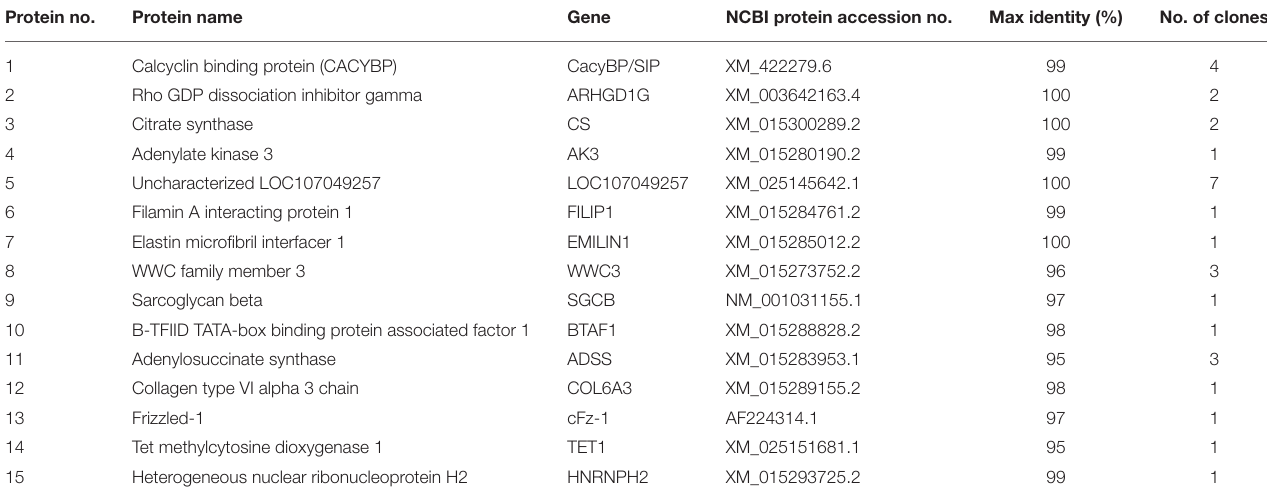
TABLE 2 | The results of the positive clones mating with V protein BLAST to NCBI. Protein